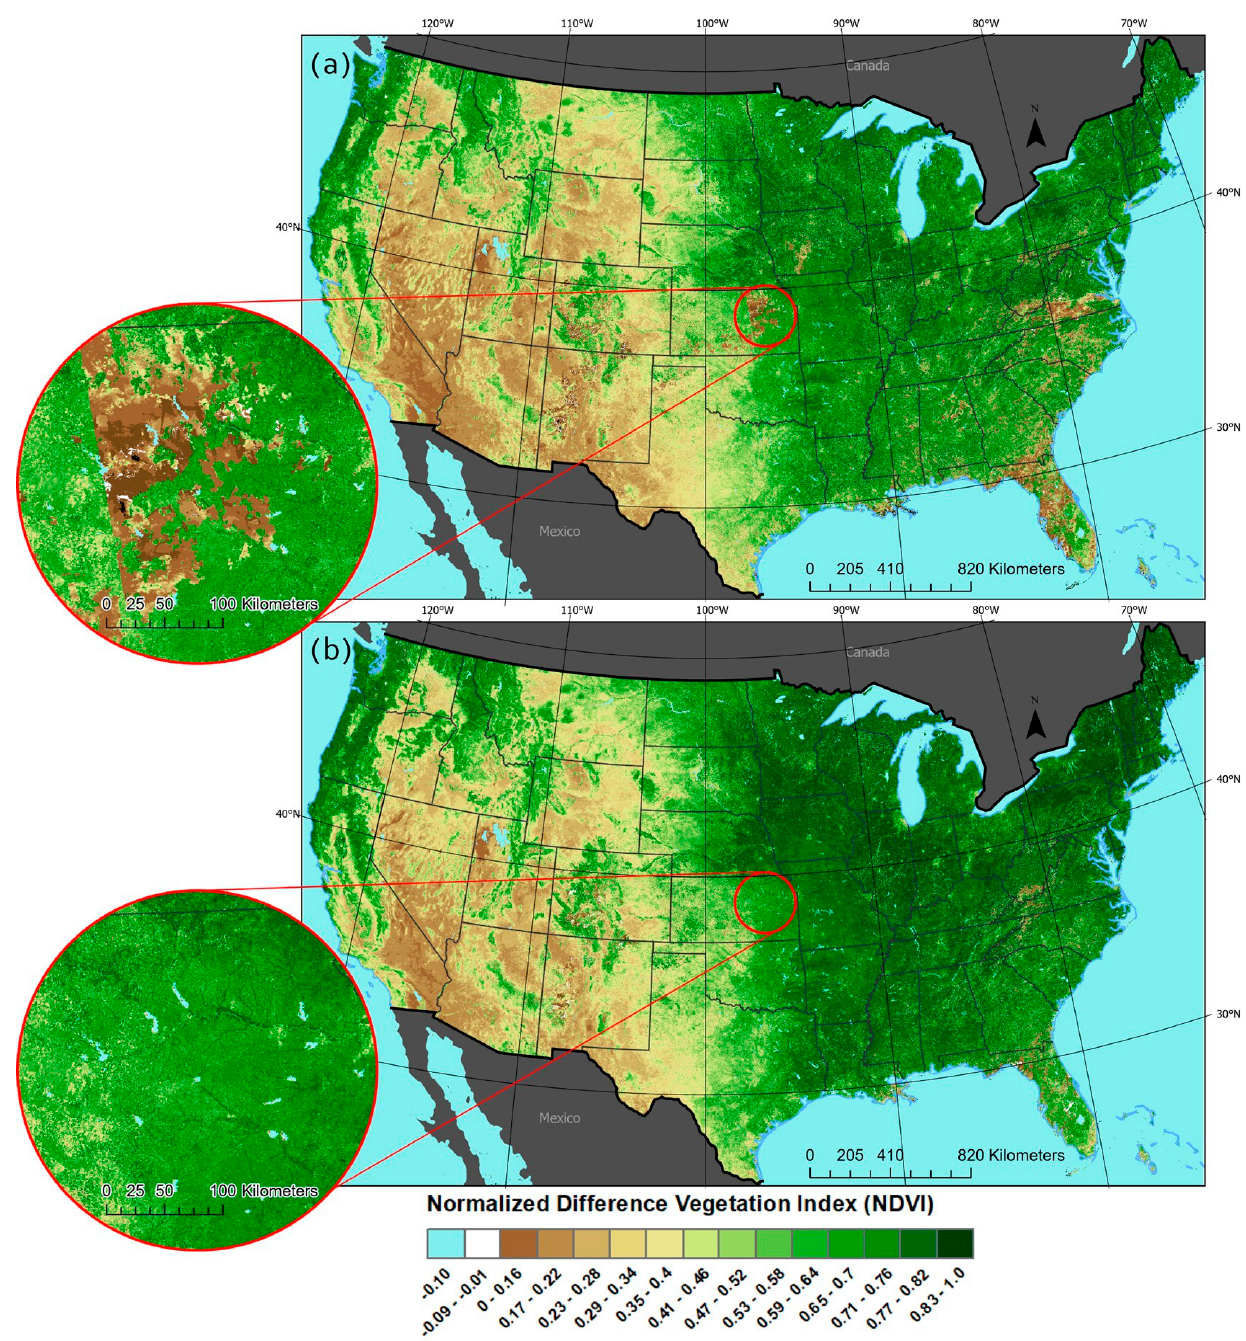
Figure 1. Expedited Moderate Resolution Imaging Spectroradiometer (eMODIS) 250-m Normalized Difference Vegetation Index (NDVI) ( a ) and expedited Visible Infrared Imaging Radiometer Suite (eVIIRS) 375-m NDVI ( b ) for composite (Julian day of year 215–221), 2016. Highlighted location in eastern Kansas shows an example of how eVIIRS composites have less noise artifacts than eMODIS